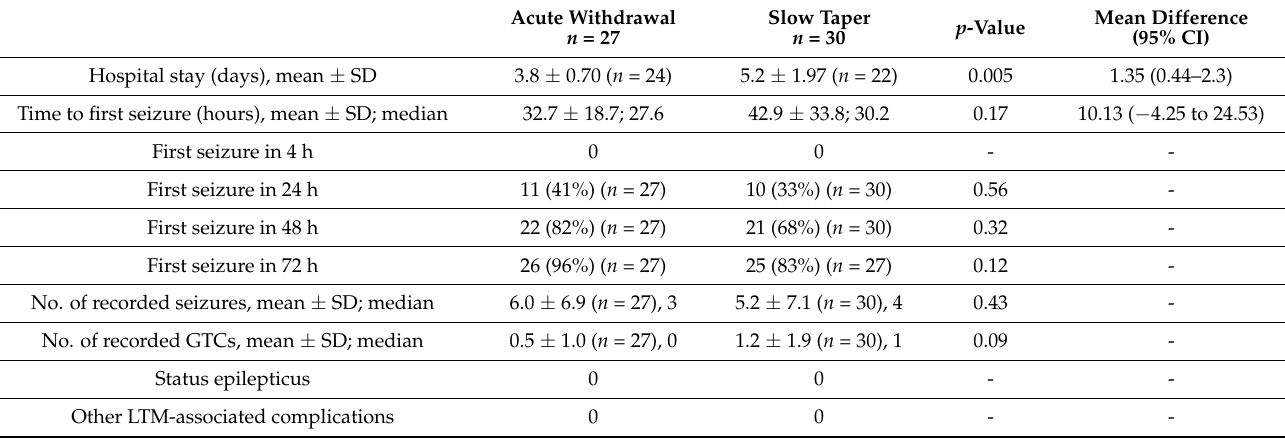
Table 3. Length of hospital stay, time to first seizure, number of recorded seizures, and